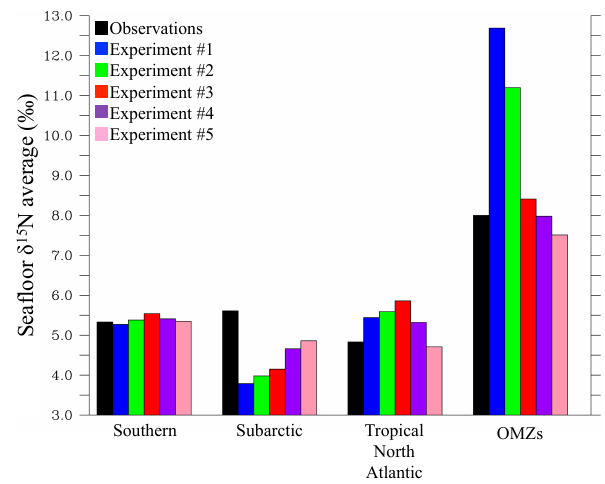
Fig. 4. Comparison of average seafloor δ 15 N in the Southern Ocean (50–75 ◦ S), subarctic/Arctic Ocean (50–75 ◦ N), tropical North At- lantic (0–25 ◦ N), and oxygen minimum zones (O 2 < 10µM) with observational values in parenthesis. Note we include locations of observed and simulated OMZs to account for the displaced model OMZs in this